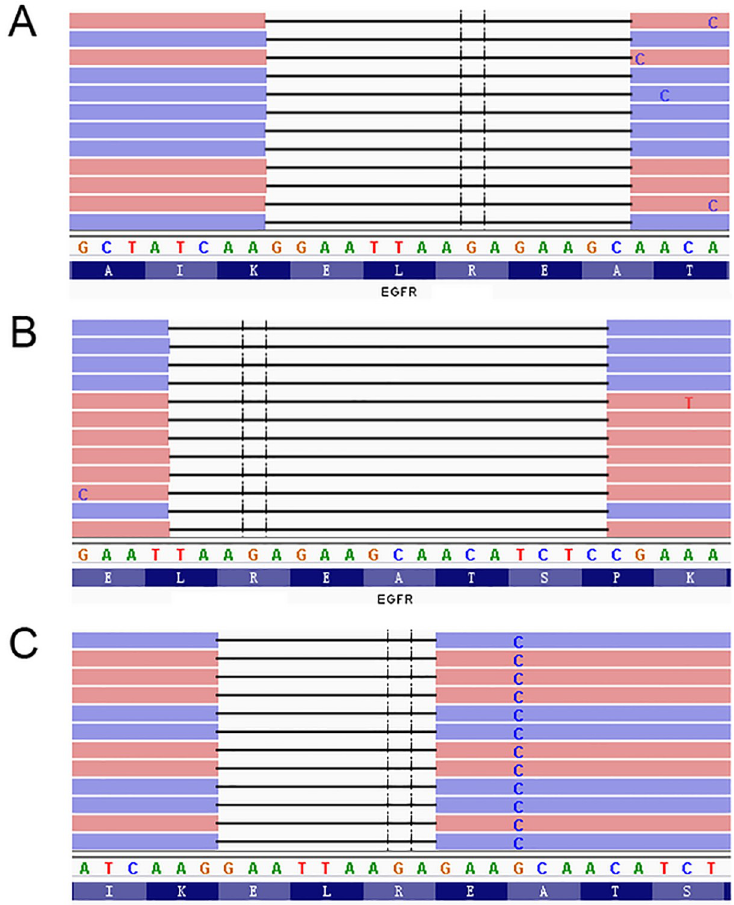
Fig 1. Three mutation subtypes of EGFR exon19. The mutation pattern of group CD(codon deletion), with a deletion of one or more original codons(A); The mutation pattern of group CSS(codon substitution and skipping), with a deletion of one or two nucleotides but the residues could be translated into a new amino acid without changing following amino acid sequence(B); The mutation pattern of group CD/CSS+SNV(codon deletion or codon substitution and skipping plus SNV), exclude CD or CSS, there’s another SNV nearby the deletion region(C).